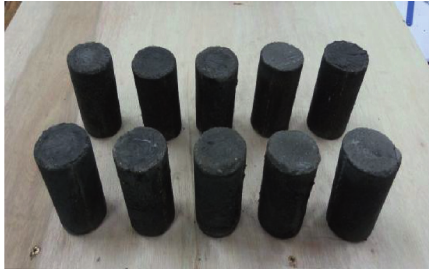
Figure 1: Molds of experimental specimens.